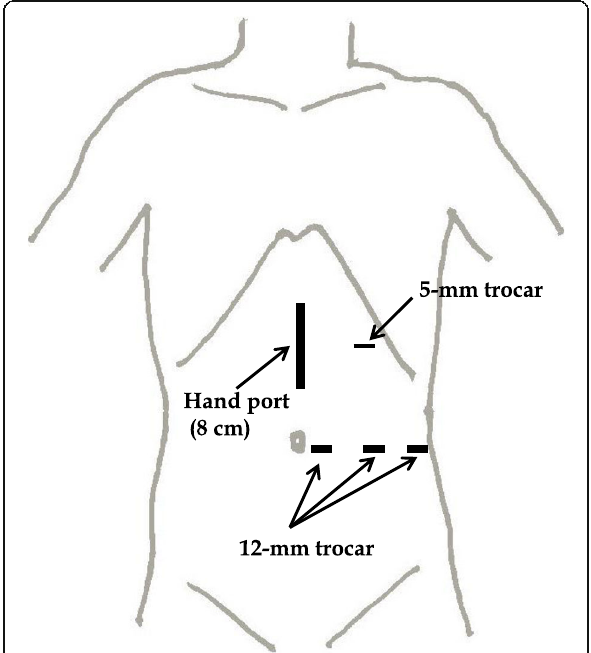
Fig. 1 Skin incision and port placement of hand-assisted laparoscopic devascularization and splenectomy. An 8.0-cm upper midline incision was made to introduce a hand port. After the abdomen was insufflated to 10 mmHg with carbon dioxide, the first trocar (12 mm) was inserted on the left side of the umbilicus. A flexible-type laparoscope was placed into the abdomen. Two other 12-mm trocars were inserted under laparoscopic observation to the left of the first trocar and on the left flank of the anterior axillar line, respectively, and one 5-mm trocar was inserted into the left subcostal